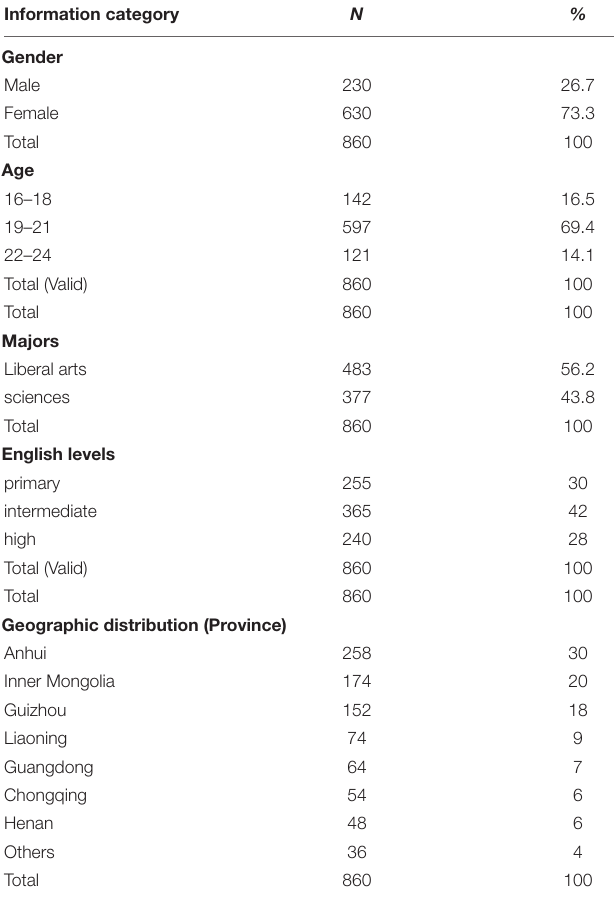
TABLE 1 | Demographic information of the language